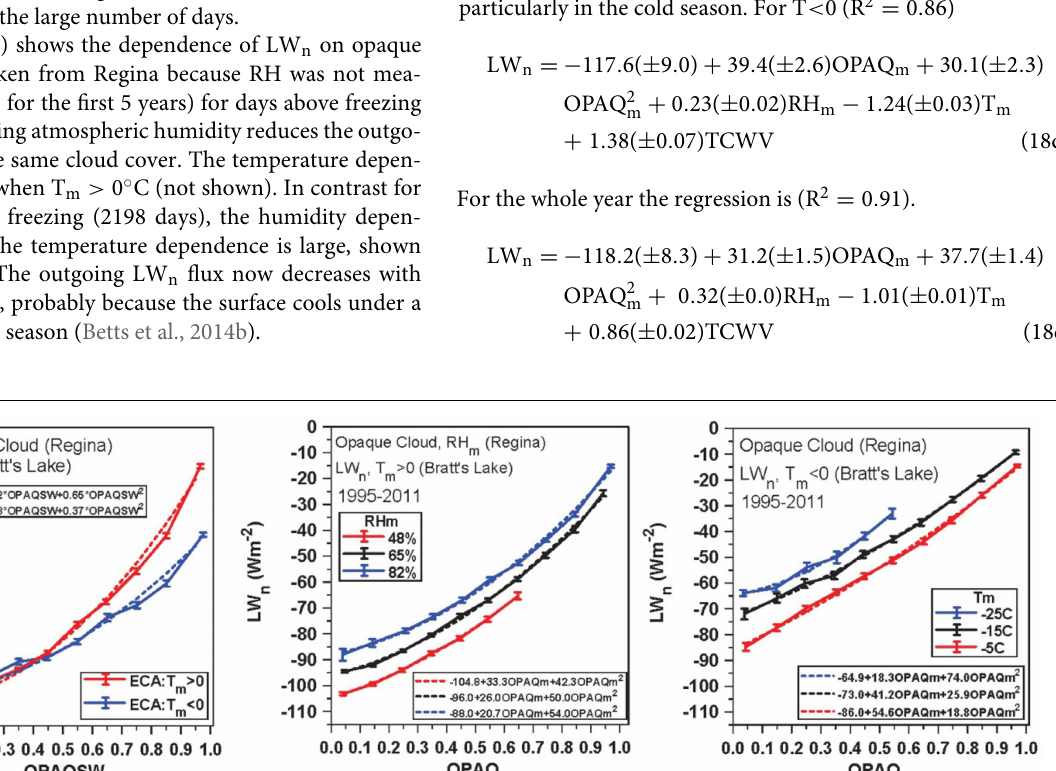
Frontiers in Earth Science |